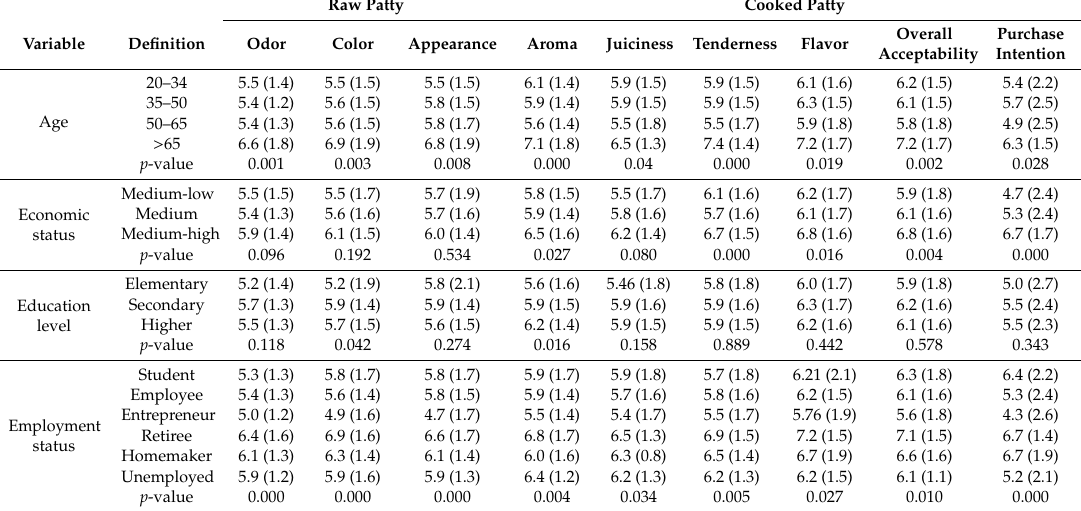
Table 4. Least square means (LSM), standard deviation (SD), and p -values of consumer scores for sensory descriptors of the raw and cooked patties (conventional, and modified with olive and linseed oil mixture and vitamin D 3 ) according to sociodemographic